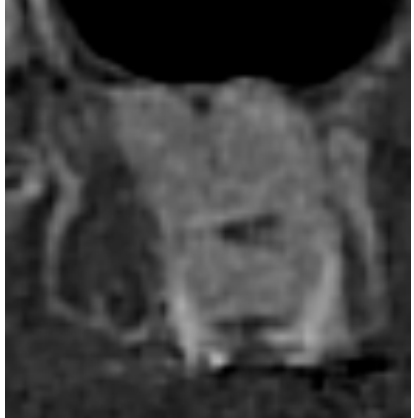
Figure 2. I—the impacted teeth.